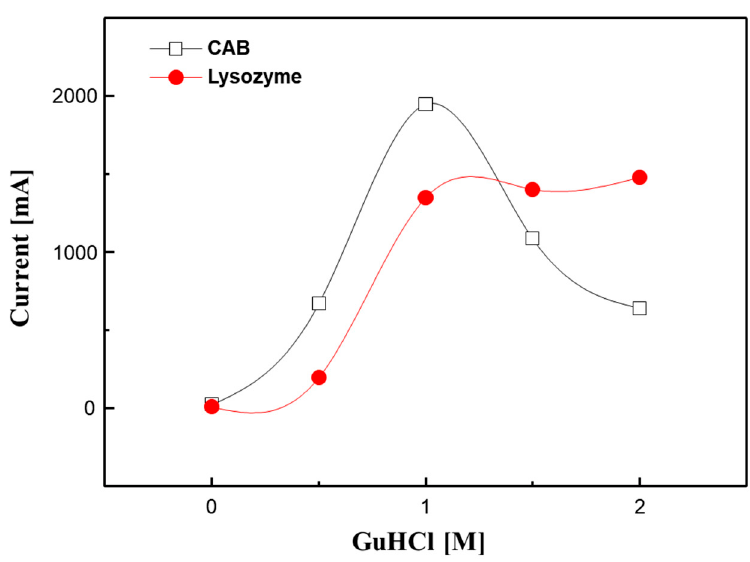
Figure 5. Response electrochemical current behavior of POPC/CHT electrode on the denatured CAB and lysozyme in the presence of GuHCl for denature proteins. Detection condition; +290 mV (vs. Ag/AgCl), 0.05 M phosphate buffer (pH 7.5).